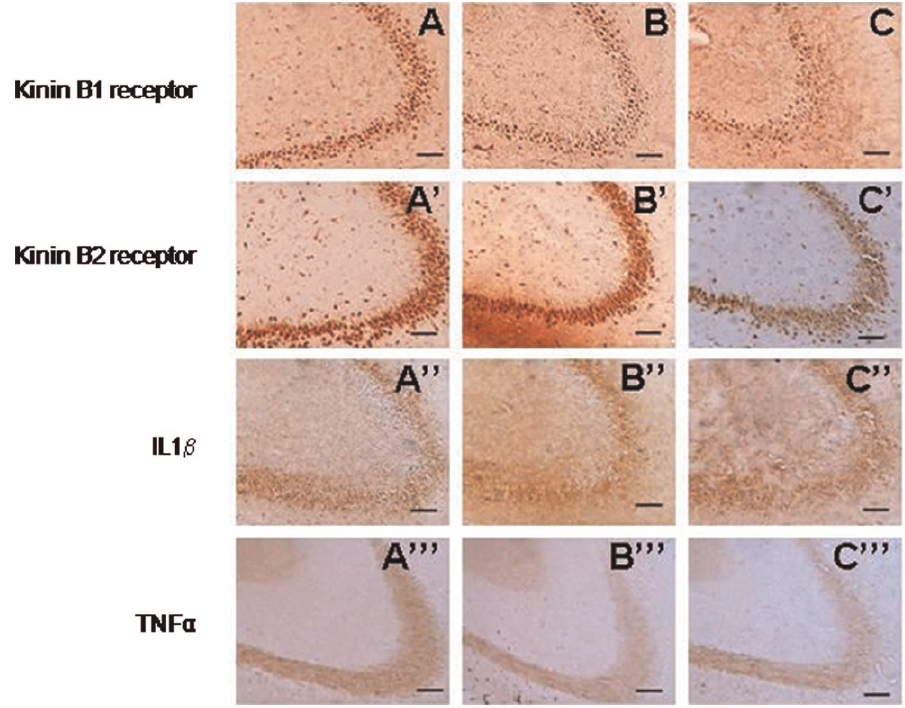
Figure 3 - Photomicrographs of the CA3 region of hippocampi processed for immunohistochemistry showing expression of the kinin B1 receptor (A, B and C), the kinin B2 receptor (A’, B’ and C’), IL1 b (A’’, B’’ and C’’) and TNF a (A’’’, B’’’ and C’’’). Groups: A – saline-treated group; B – pilocarpine-treated group; and C – indomethacin-treated group. Scale bars: 0.02